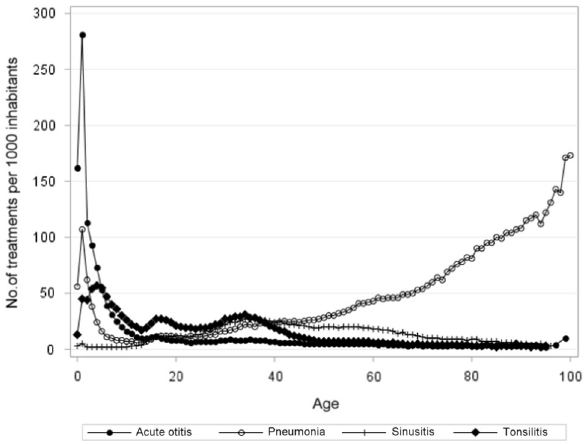
Fig. 1 Antibiotic use for patients with acute respiratory tract infections by age